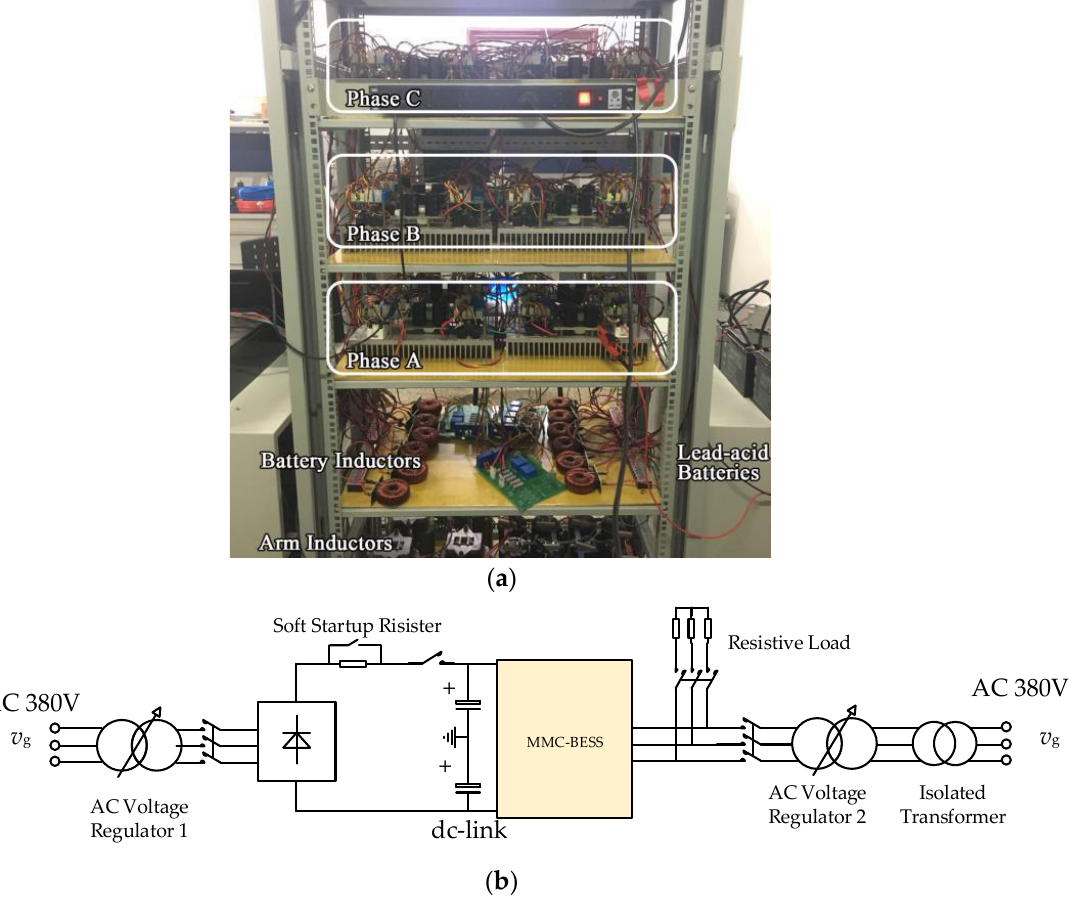
Figure 16. Configuration of the three-phase MMC-BESS prototype. ( a ) Picture. ( b ) Circuit.